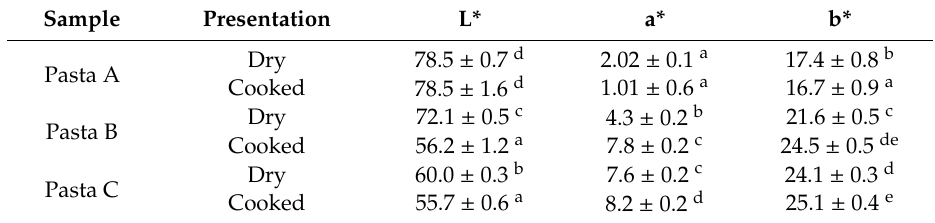
Table 4. Color parameters in dry and cooked pasta.